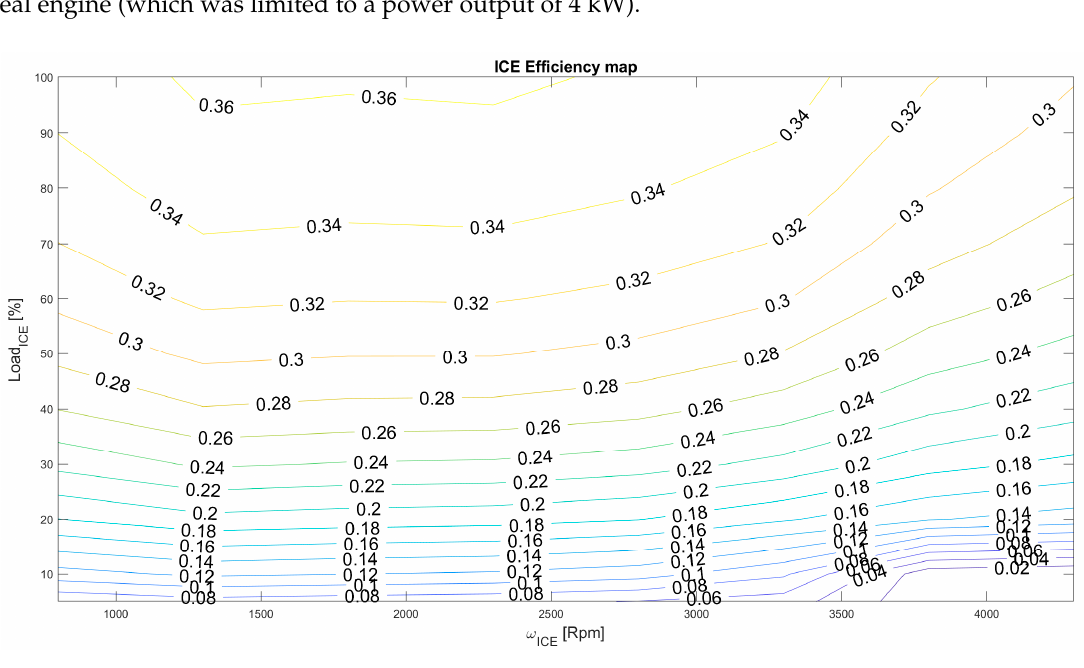
Figure 2. ICE map efficiency vs Rev/min and Load%. Figure 2. ICE map e ffi ciency vs Rev / min and